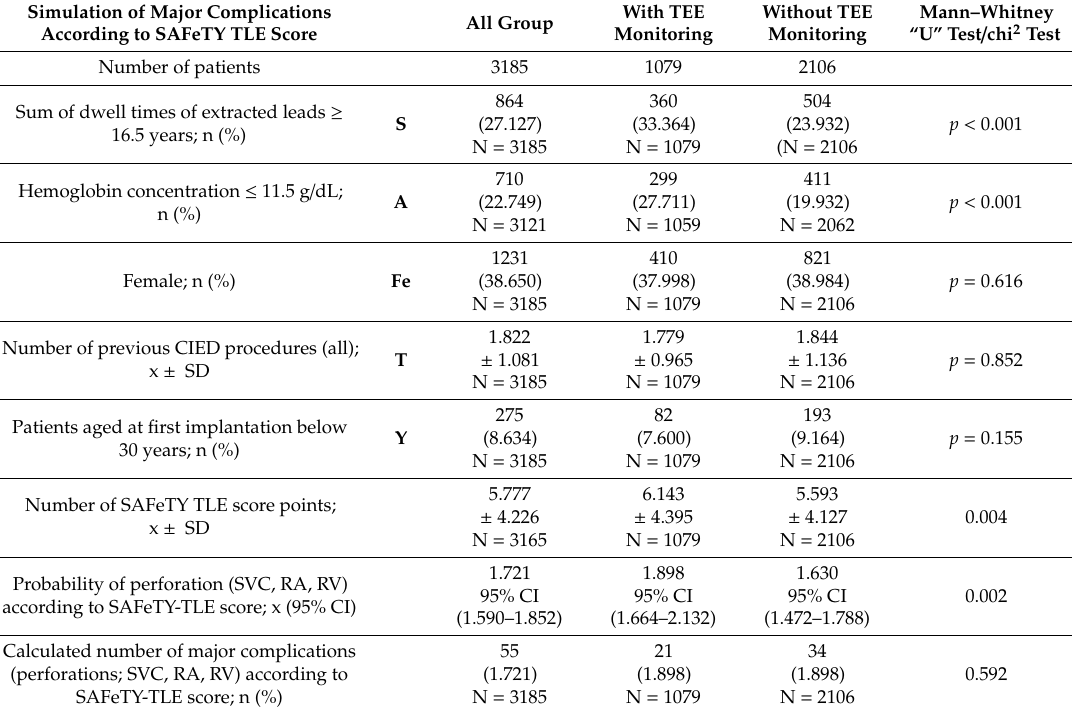
Table 4. Simulation of major complications according to the SAFeTY TLE score in the validation cohort.